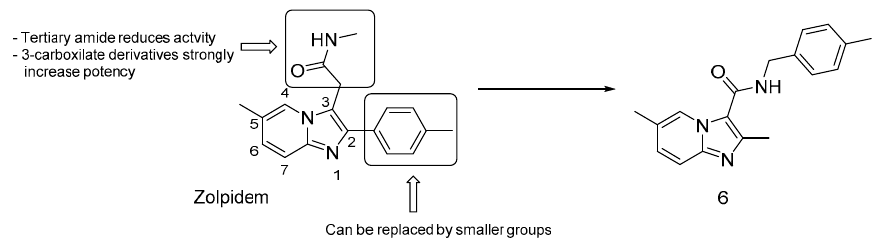
Figure 14. The chemical structure of Zolpidem and SARs of its analogues.